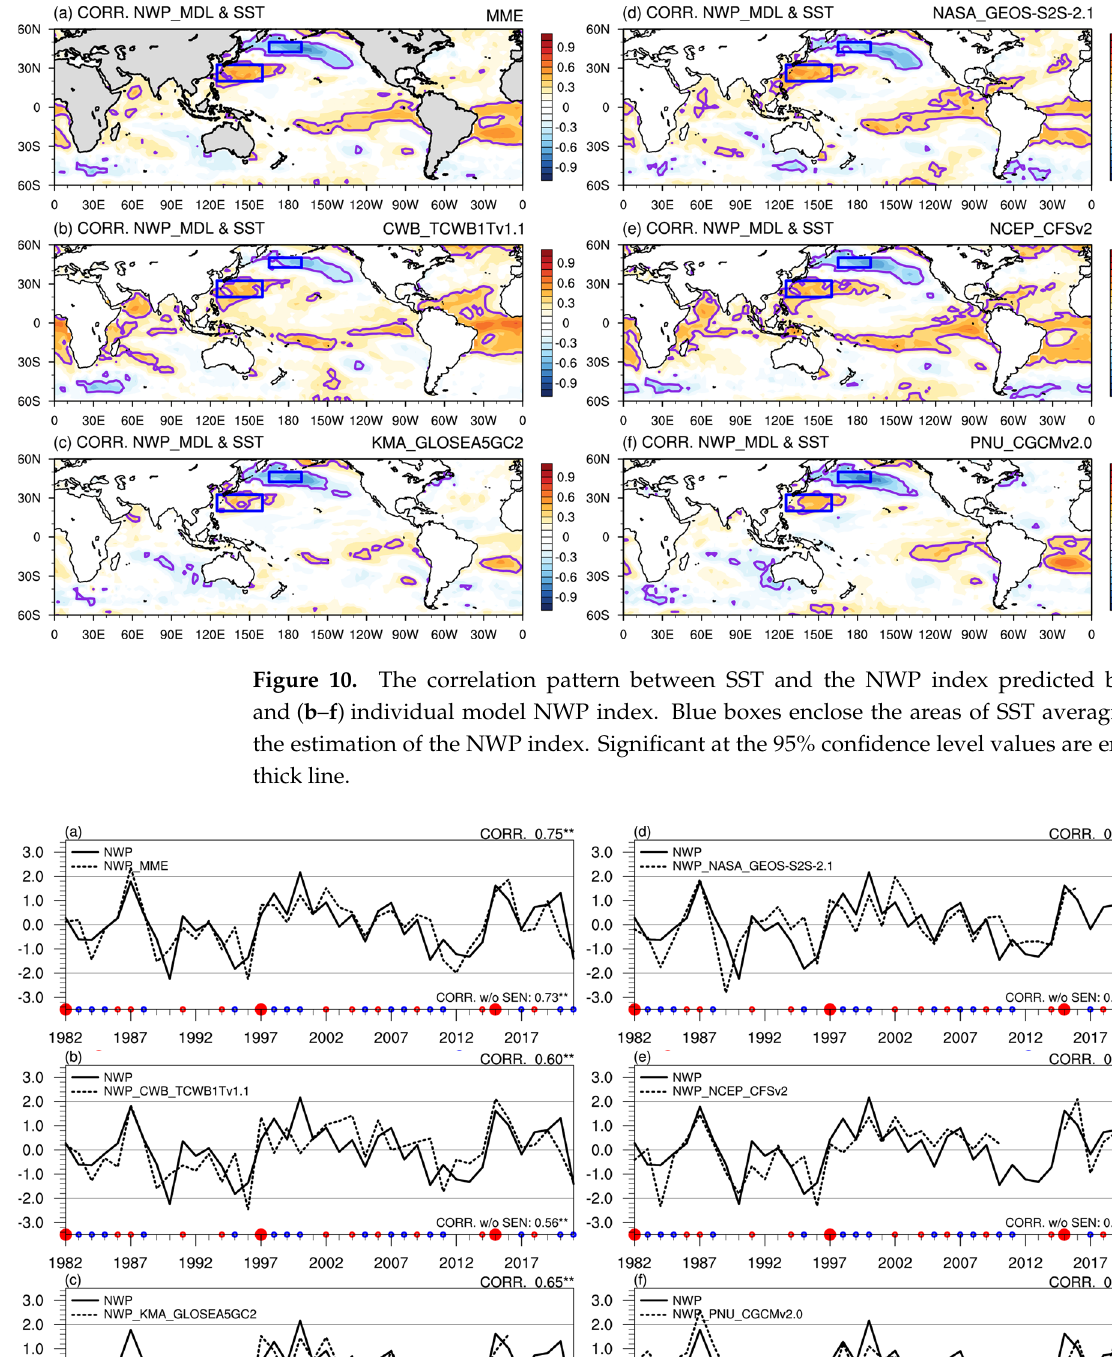
Figure 12. Time series of the WP index (solid line) and the NWP index (dashed line) predicted by ( a ) MME and ( b – f ) individual models. The TCC for the entire series (series without SEN years) is